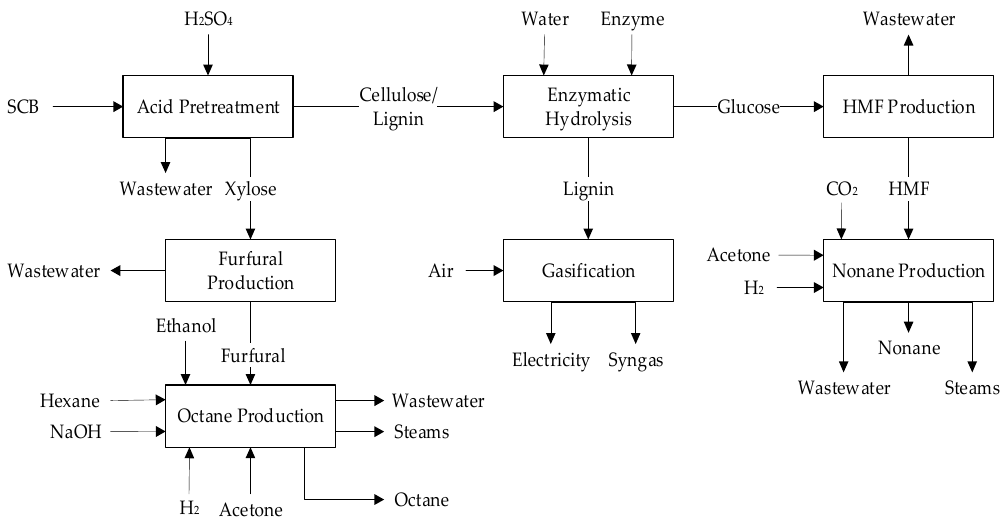
Figure 1. Flowsheet for SCB processing. Table 1. Composition of sugarcane bagasse (SCB) employed in this work [39].